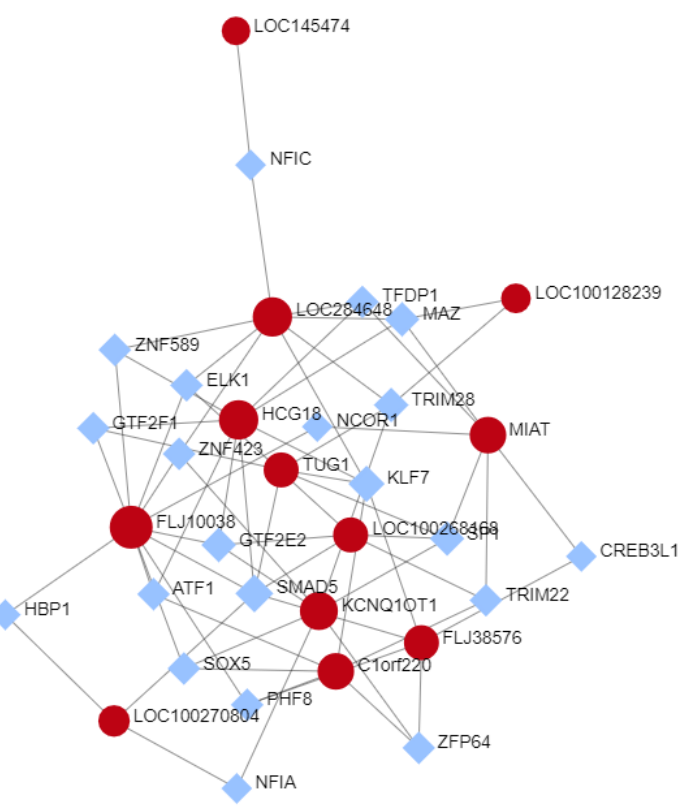
Figure 6. Networks of TF-lncRNAs interaction created by the NetworkAnalyst website. The lncRNA are represented as red circles, and coding mRNAs, as blue diamonds.) The nodes represent functions and edges are determined by the overlap ratio between genes associated with the two func- tions.